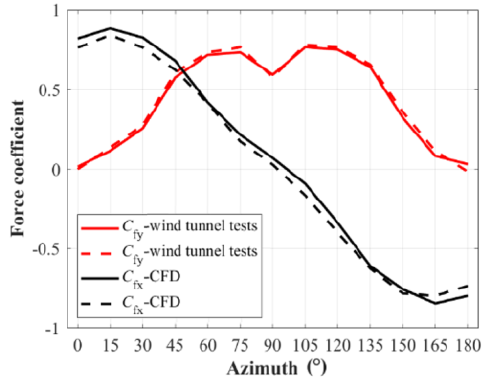
Figure 9. Drag coefficient values in current and previous studies.